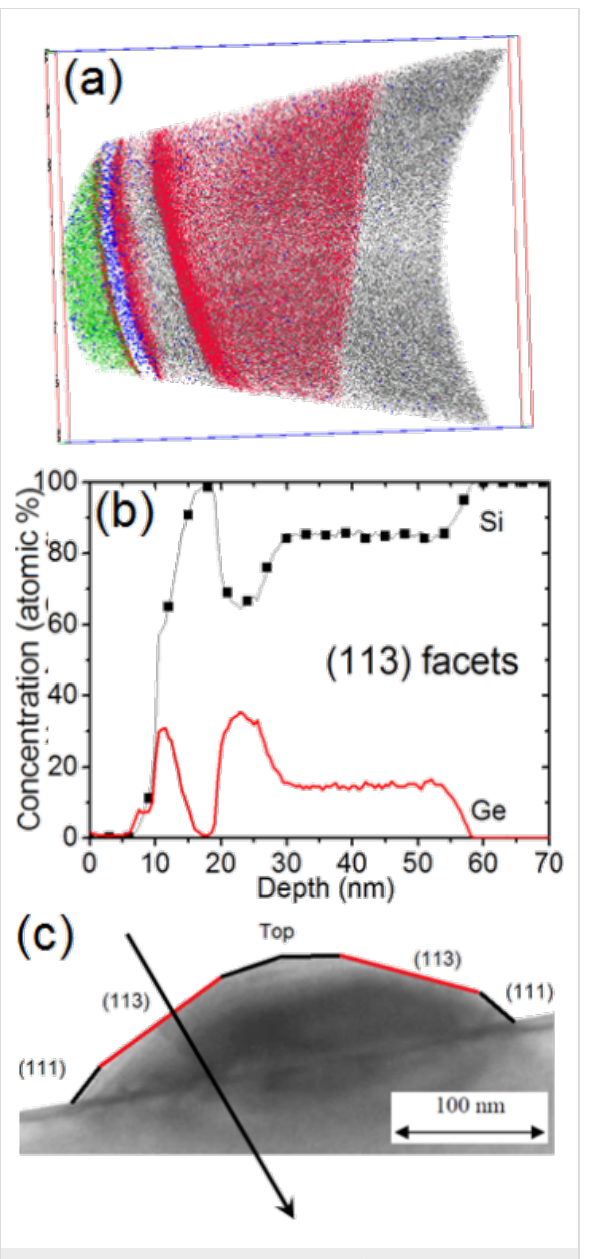
Figure 10: (a) APT volume (70 × 70 × 85 nm 3 ) and (b) Si and Ge 1D concentration profiles measured in this volume. Figure 10c indi- cates the direction in which the concentration profiles were measured in the island.